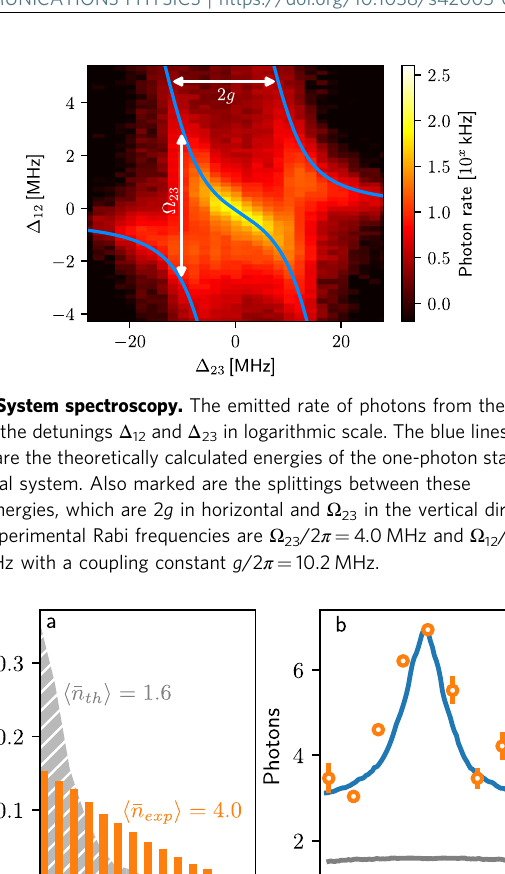
dimensional scan of the detuning Δ 12 against Δ 23 . This scan reveals the complex energy landscape in the fi rst manifold that shows two avoided crossings. The highest photon generation rate is reached on resonance, Δ 12 = Δ 23 = 0, with a rate of the order of 100 kHz.